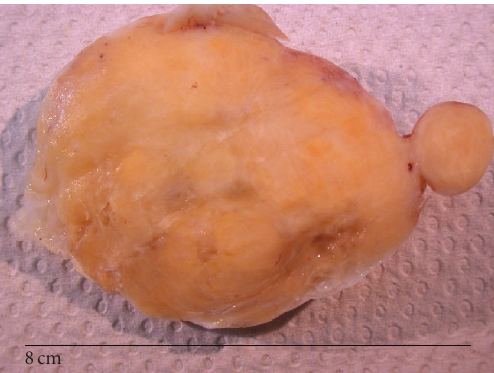
Figure 1: Recurring MECF macroscopic findings. Regular, lobu- lated, firm, and fibrous yellow-white tumours.